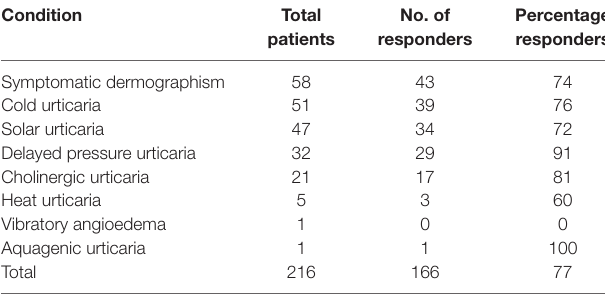
TAble 3 | Summary of chronic inducible urticaria patients showing a complete or partial response to omalizumab reported in case reports, case series, and clinical